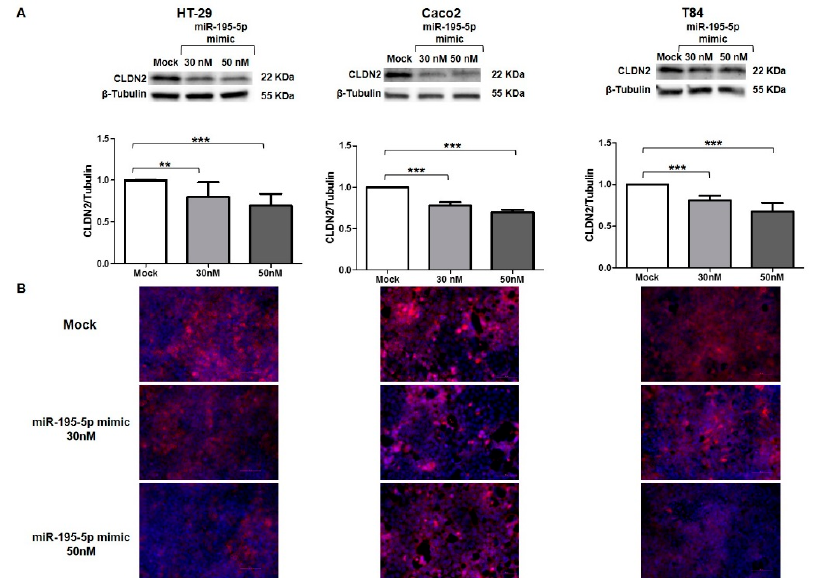
Figure 5. Regulation of CLDN2 protein expression by miR-195-5p in colonic epithelial cell lines. (A) Western blot analysis of CLDN2 protein expression in HT-29, Caco2, and T84 cell lines after miR-195-5p mimic transfection. A significant reduction of CLDN2 expression was detected in all cell lines. Raw data of the independent experiments of Western blot were reported in Appendix A. (B) Immunofluorescence staining of CLDN2 in HT-29, Caco2 and T84 cell cultures after miR-195-5p mimic transfection. In accordance with Western blot results, after transfection, the expression of CLDN2 decreased compared with mock-control. Single channel images of DAPI and CLDN2 staining before merge were reported in Appendix B. Data of WB were obtained by dividing the normalized transfected sample values by the normalized control sample values. β -Tubulin was used as housekeeping protein to normalize the data. Data are representative of four independent experiments. The histograms correspond to mean ± SEM. Scale bar = 50 μ m ** p < 0.01; *** p < 0.001.